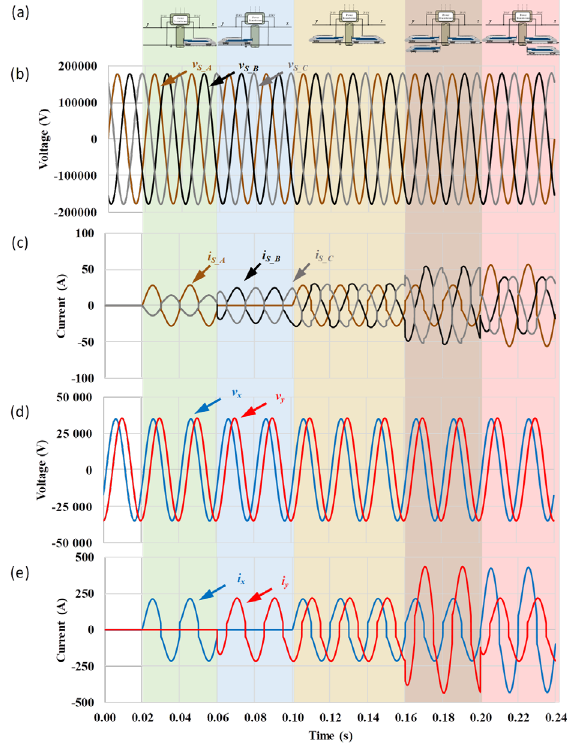
Figure 4. Simulation results of the railway system powered by a V/V power transformer: (a) Case scenarios with different number of locomotives in the catenaries; (b) Three-phase power grid voltages v S_A , v S _ B and v S_C ; (c) Three-phase power grid currents i S_A , i S _ B , i S_C ; (d) Voltage in the catenaries, v x and v y ; (e) Currents in the catenaries, i x and i y .